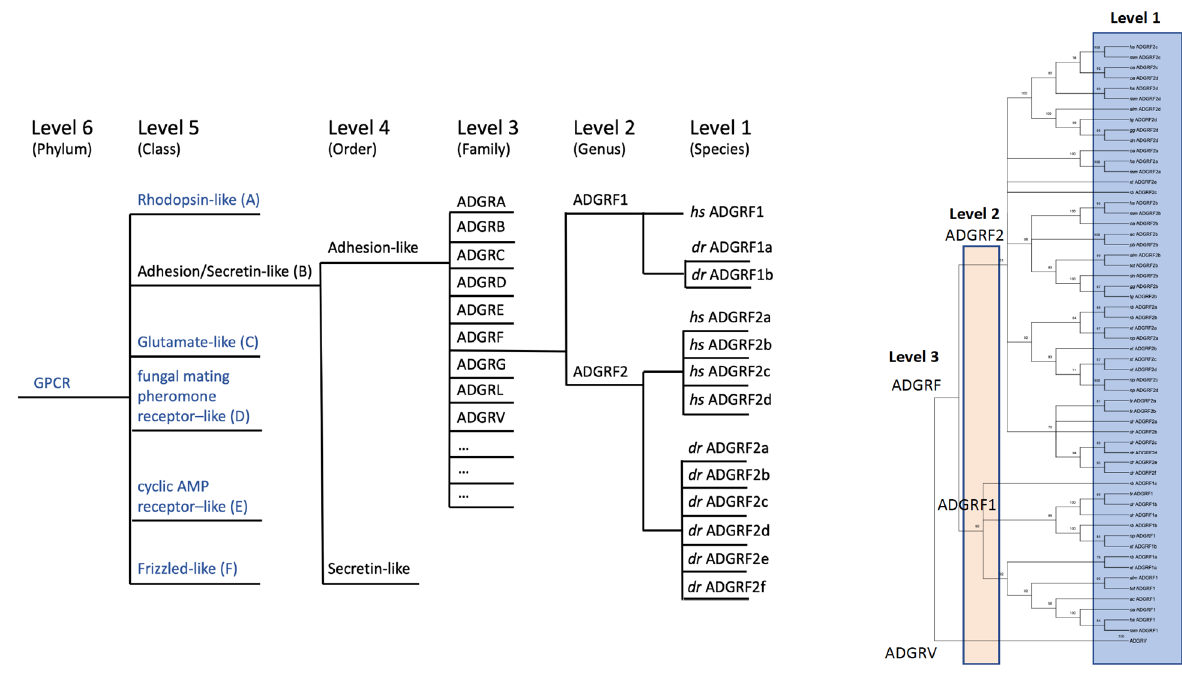
Figure 4. Hierarchy-based nomenclature of aGPCRs. Based on clustering analyses of the 7TM domain the previously suggested nomenclature of aGPCRs [19] was revised. We applied our recently introduced hierarchic level systematics. Level 4 (order) divides secretin-like receptors and aGPCR (ADGR). We extended level 3 (families) to an open nomenclature (ADGRA, B, C, …) where even new families (e.g., ADGRN in other chordates shown in Figure 5) can be newly defined, and assigned level 2 (e.g., ADGRF1, ADGRF2) only to those aGPCRs where a clustering-supported orthology was found between fish and mammals. Individual receptors that descend from level 2 by radiation or duplication are marked by additional lower characters (e.g., dr ADGRF1a, dr ADGRF1b). dr : Danio rerio , hs : Homo sapiens. Table 2. Proposed nomenclature of human aGPCRs based on phylogenetic clustering in vertebrates. The old and new nomenclatures of human aGPCRs are given. Revised names which are different to the previous annotation [9] are marked in grey. * pseudogene in human.